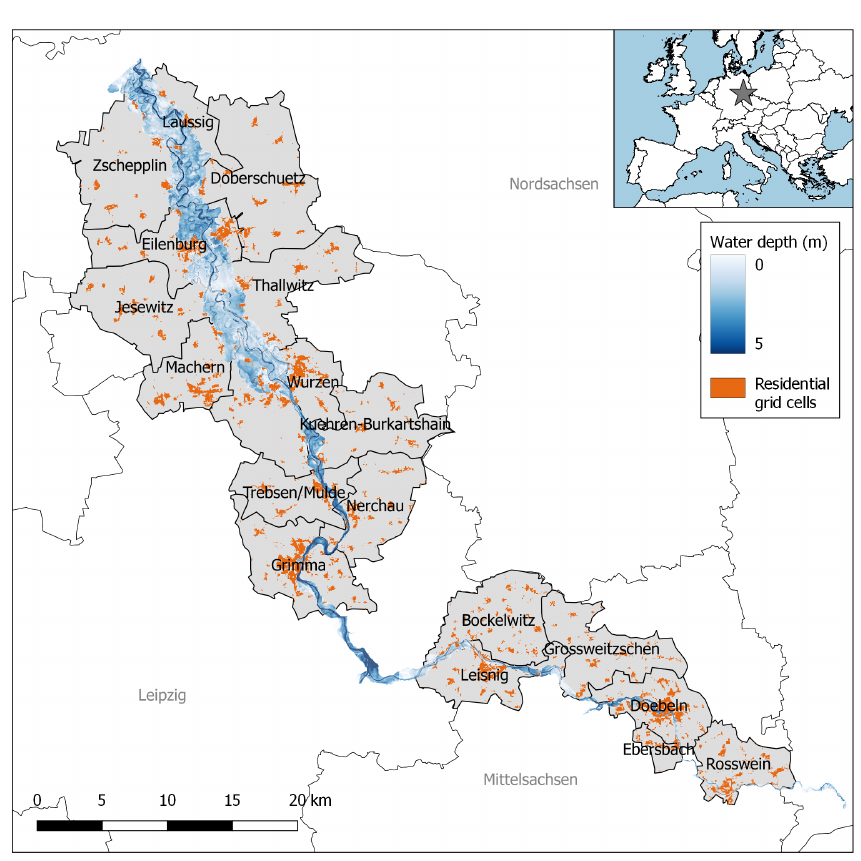
Figure 1. 2002 flood along the Mulde River, in Germany. The figure shows the municipalities considered in the case study (grey), the estimated flood extension and water depths (blue), and the location of the residential grid cells